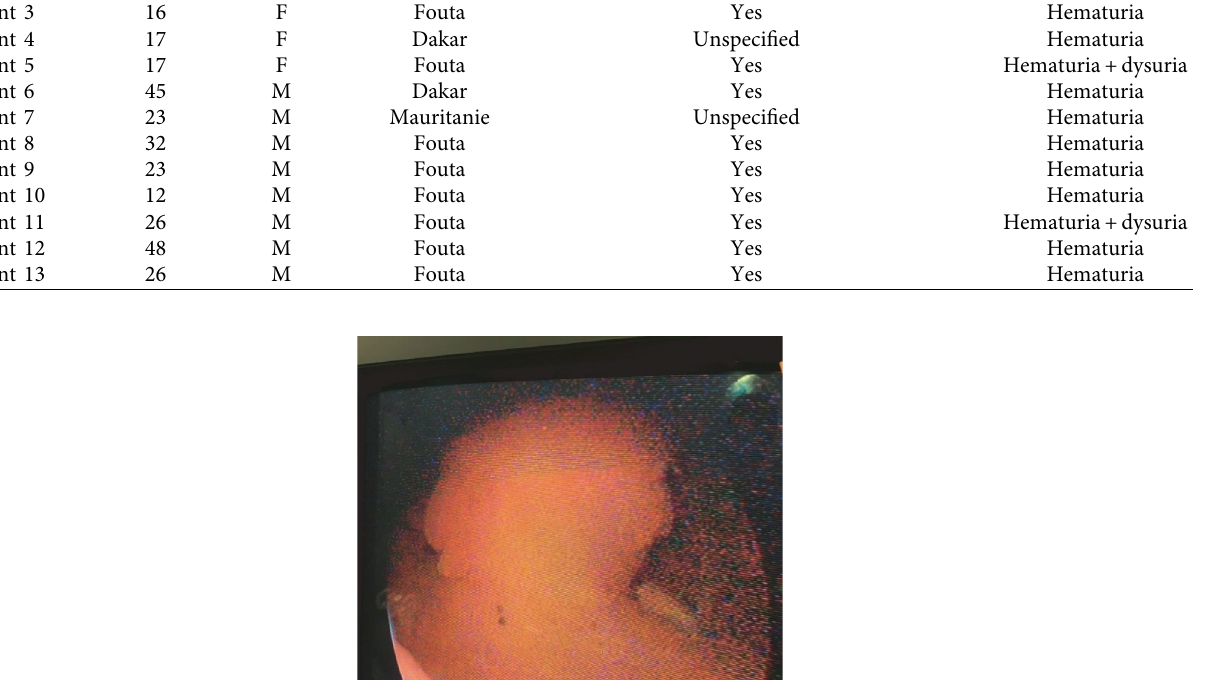
Figure 1: Polyp sitting around the left ureteral meatus viewed with